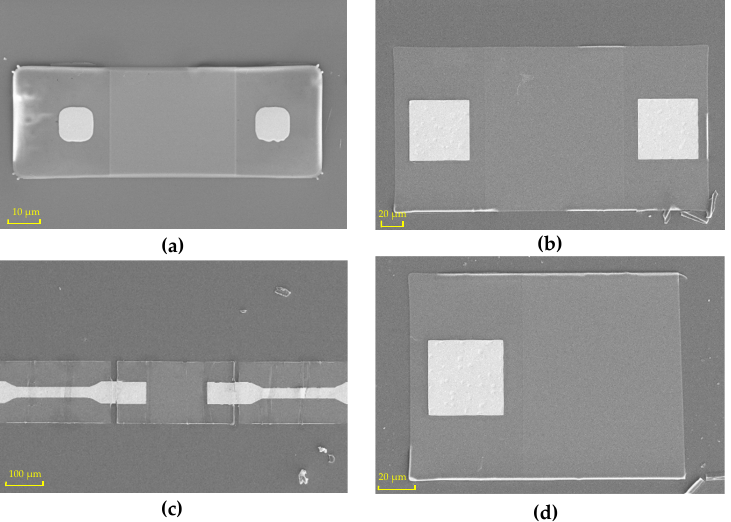
Figure 4. Characterization of silicon nanomembranes on PDMS flexible substrate after the second transfer. ( a ) Morphological features of silicon nanomembrane with a size of 100 × 40 μm 2 ; ( b ) morphological feature of silicon nanomembrane with a size of 300 × 160 μm 2 ; ( c ) morphology feature map of the silicon nanomembrane with continuous metal strips on both sides and middle silicon nanomembrane size of 300 × 160 μm 2 ; ( d ) morphology feature map of the broken silicon nanomembrane after the transfer.